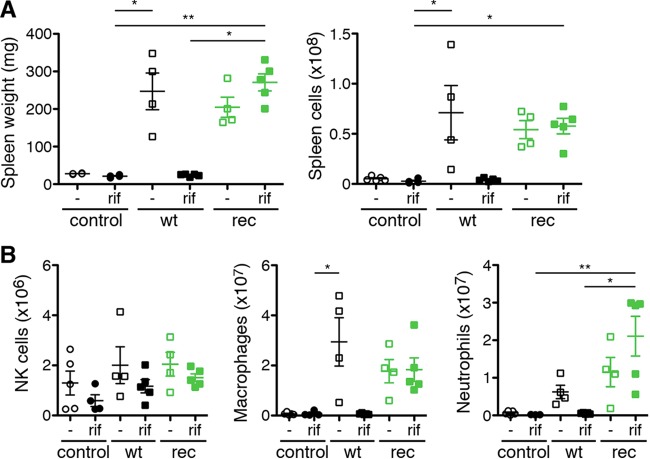
R. typhiGFPuv-infected CB17 SCID mice develop splenomegaly comparable to that of animals infected with wild-type R. typhi. CB17 SCID mice infected with R. typhiGFPuv or wild-type R. typhi without antibiotic treatment developed splenomegaly, indicated by increased spleen weight and cell count (A). (B) NKp46+ NK cells were generally not significantly enhanced (left), while increased numbers of both CD11b+ GR1low macrophages (middle) and CD11b+ GR1high neutrophils (right) were observed. Each symbol represents a single mouse. In addition, means ± standard errors of the means (SEM) are shown. Statistical analysis was performed using one-way ANOVA (Kruskall-Wallis test followed by Dunn′s posttest). The asterisks indicate statistically significant differences (*, P < 0.05; **, P < 0.01).